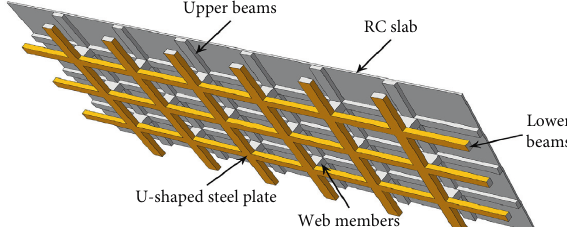
Figure 1: U-shaped steel-concrete composite hollow waffle